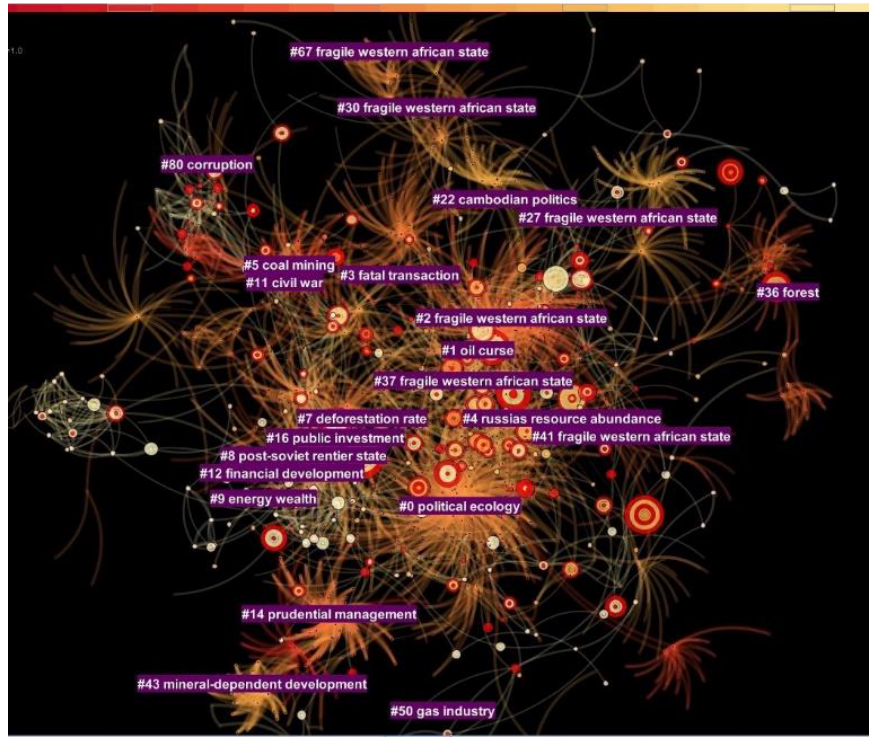
Figure 28. The landscape picture of the reference co-citation framework from 1993–2020.